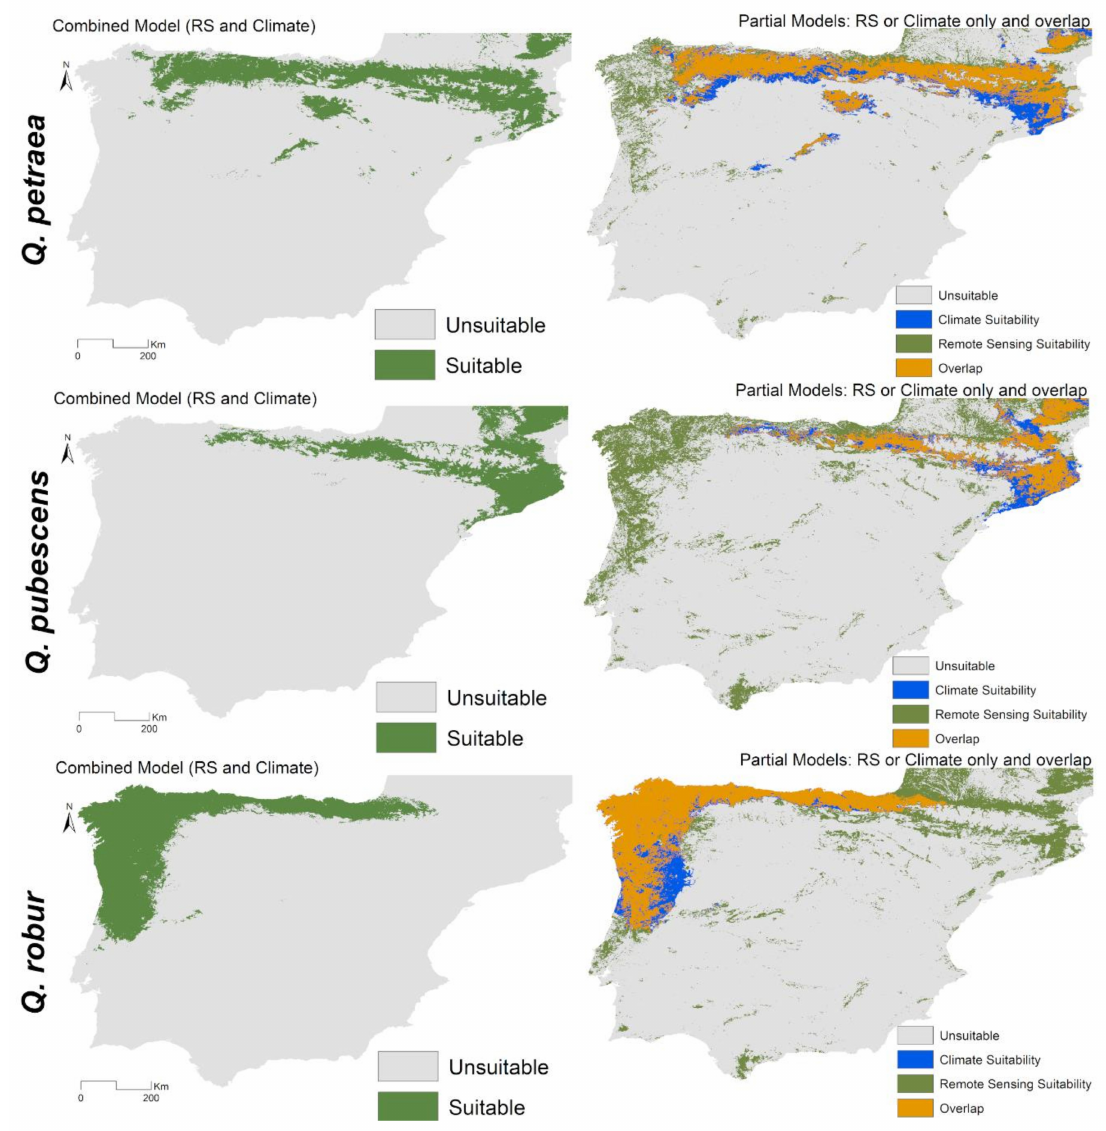
Figure A4. Combined models (remote sensing—RS and climate) (Left) and partial models (RS or climate and overlap) (Right) for Q.petraea, Q. pubescens and Q. robur